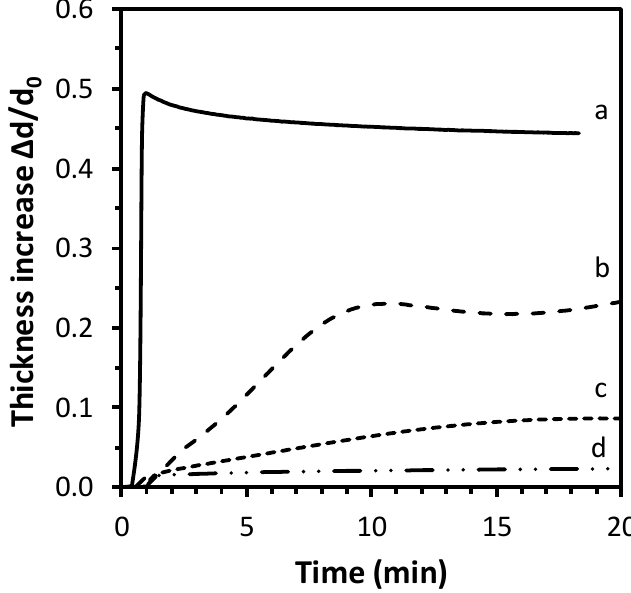
Figure 2. Swelling behavior, in terms of thickness increase, Δ d/d 0 , of different iCVD coatings with 29% (a), 60% (b), 70% (c) and 85% (d) EGDMA. The error bar in the measurements is ± 1%.